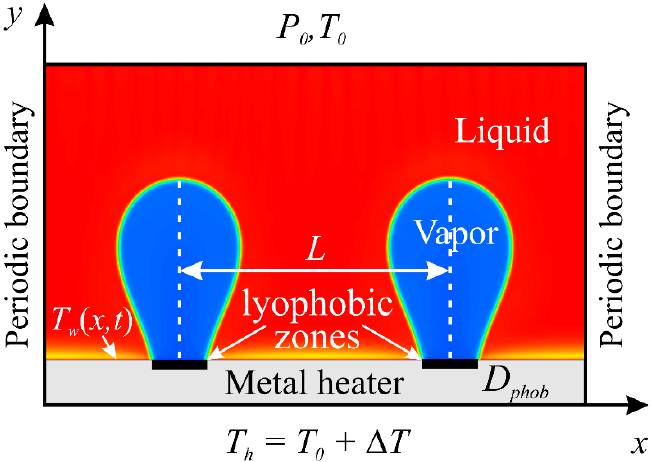
Figure 1. Computational domain and boundary conditions. Layout of the lyophobic zones on the lyophilic surface: D phob is the width of the lyophobic zones, L is the distance between the lyophobic zones.